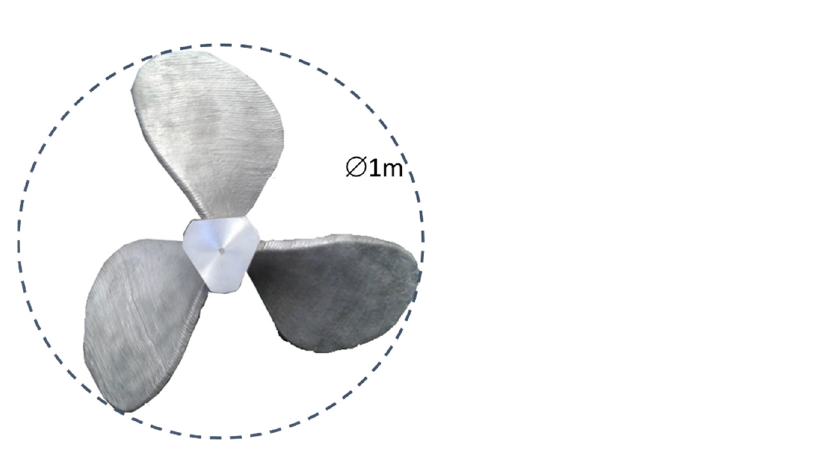
Figure 11. Numerical data chain for the propeller use case.